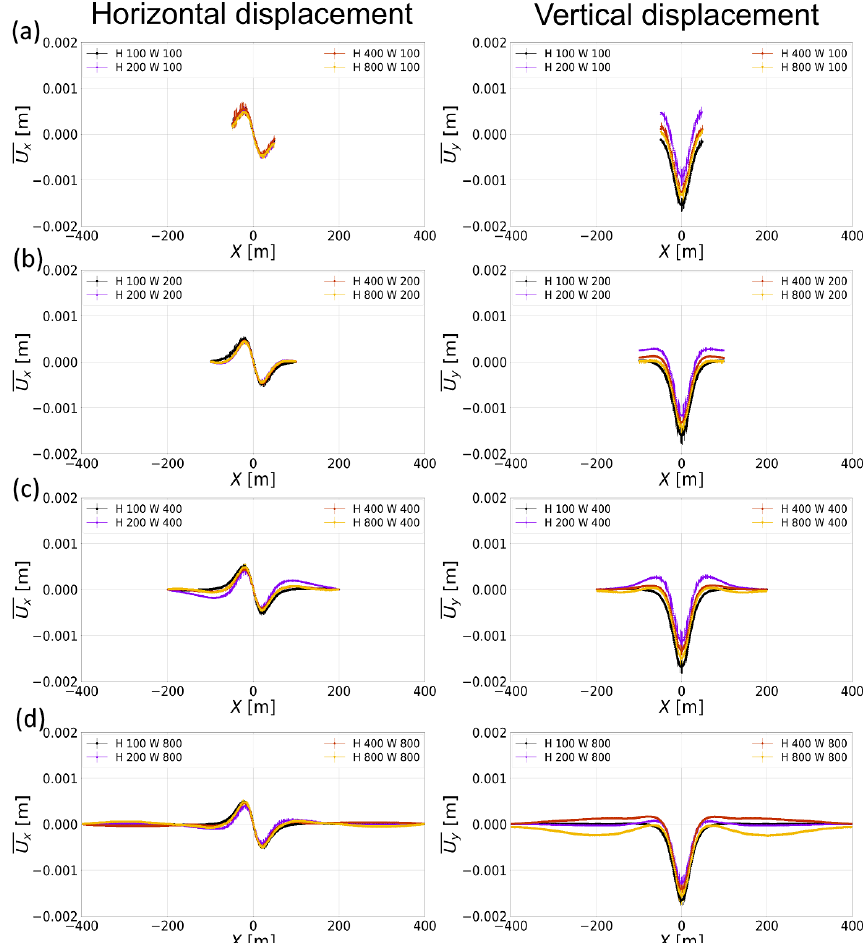
Figure B2. Convergence test results for model assembly dimensions: cavity of radius of 5m and depth of 35m created in each case by method M1. Mean particle radius is 0.74m. Left and right columns show horizontal and vertical displacement profiles, respectively. Each plot shows results for varying model height ( H ) from 100 to 800m for a given width ( W ): (a) W = 100m; (b) W = 200m; (c) W = 400m; (d) W = 800m. A convergence is observed for larger model dimensions and a minimum height of 400m is favoured. Symmetric boundaries (400 × 400m) give the most stable